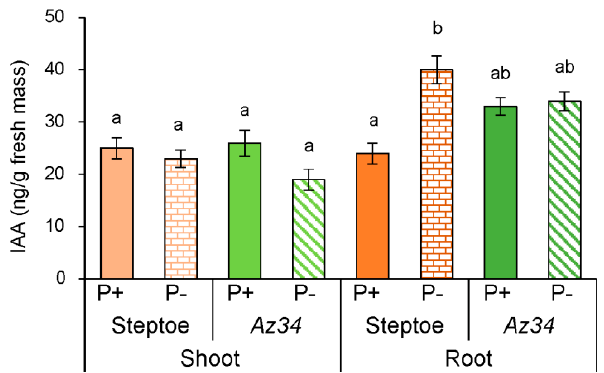
Figure 6. IAA concentration (calculated per g fresh mass) in shoots and roots of 4-days-old barley plants (cv. Steptoe and Az34 ) grown for 1 day on nutrient solutions with (P+) or without (P − ) phosphate. Bars are means ± S.E. of n = 9, with significant ( p ≤ 0.05) differences between all genotype/treatment combinations marked with different letters (ANOVA, LSD). Under P-replete conditions, Az34 had higher root tip staining for IAA (Figure 7) (inconsistent with the bulk root IAA data, which showed no genotypic differences (Figure 6)). Again, P starvation resulted in different responses between the genotypes, with immunostaining for IAA increasing in root tips of WT plants but decreasing in Az34 (Figure 7), as indicated by significant genotype × P level interaction (Table S4). Thus, P starvation tended to minimize genotypic differences in root tip IAA concentration.